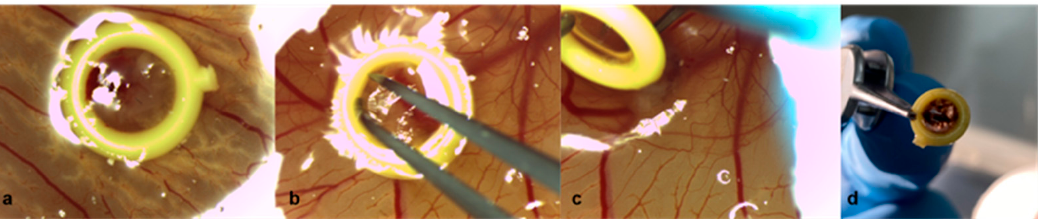
Figure 5. Removal of the rings on ED8 of uveal melanoma patient-derived tumor grafts in group 1 with Matrigel and a ring. ( a ) Tumor graft with Matrigel and a ring on ED7, ( b ) dissemination of the tumor margins along the inner circle of the plastic ring with forceps on ED8, ( c ) slowly turning and lifting the ring with a forceps while holding the graft in its implantation site with a ball burnisher to avoid involuntary explantation on ED8, ( d ) removed ring with fragments of the tumor on ED8.